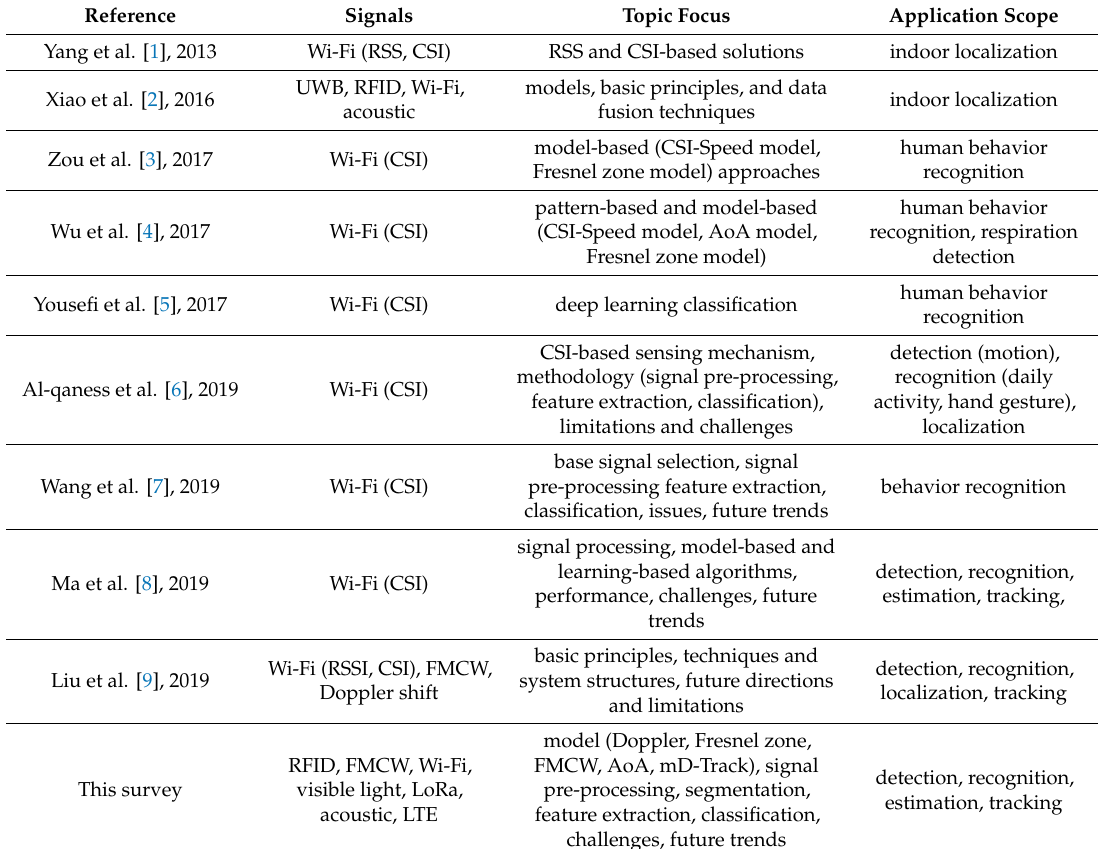
Table 1. Summary of related surveys on wireless sensing.